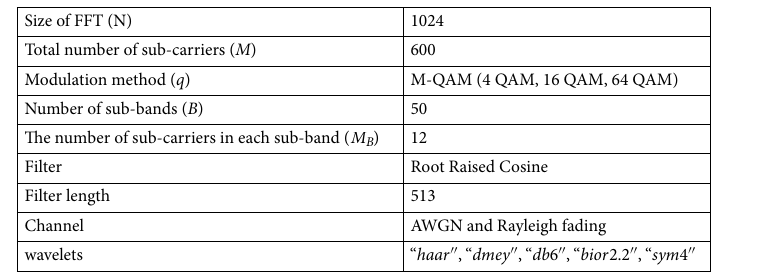
Table 1. Simulation parameters of the F-OWDM